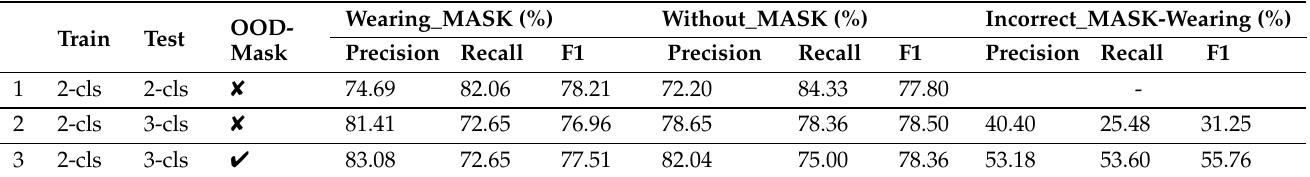
Table 5. Experiment